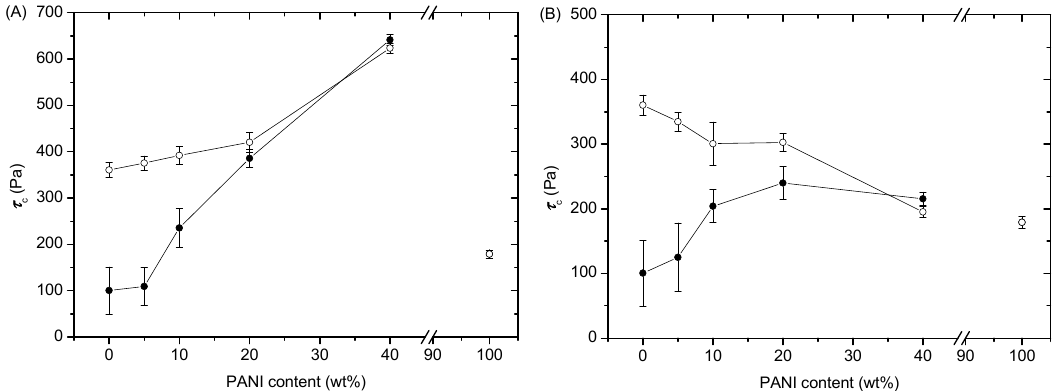
Figure 9. Critical stress as a function of PANI content for the suspensions of P[VBTMA][PF 6 ]-c-PANI ( A ) and P[VBTMA][PF 6 ]/PANI mixture; ( B ) at 2.0 kV/mm electric field. Solid points were obtained when the rotation side of the electrode was anode, and open points were obtained when the rotation side of the electrode was cathode ( φ = 27 vol %, T = 23 °C).